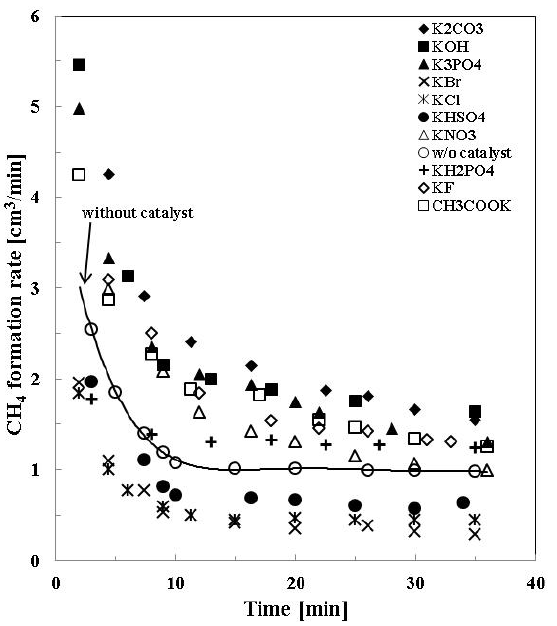
formation rate 4